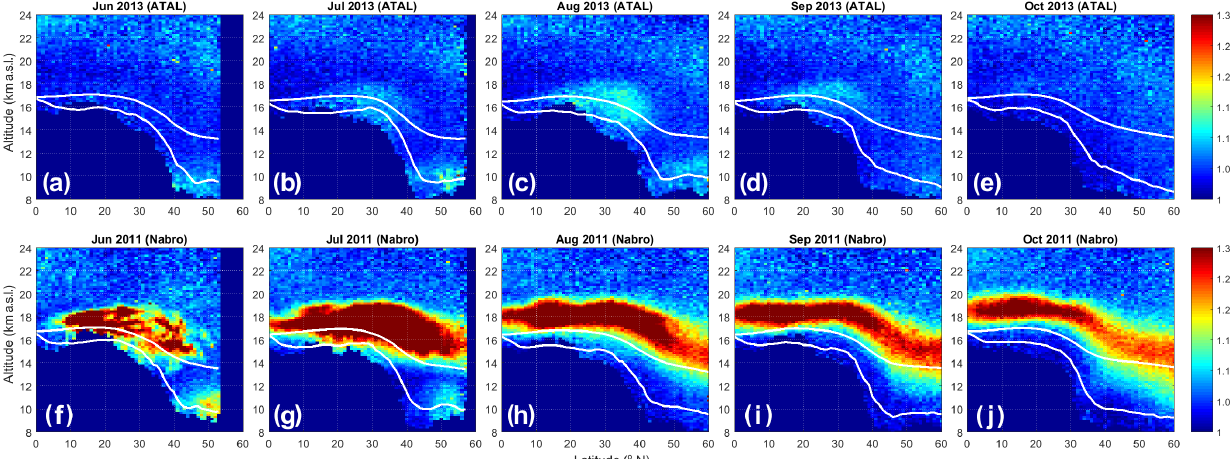
Figure 8. Latitude and altitude distribution of scattering from aerosol in the stratosphere and the UT. Two series, from 2013 (upper row, a–e ) and 2011 (lower row, f–j ), show the monthly mean 532nm wavelength scattering ratio from June to October without and with, respectively, fresh volcanic influence. The former series allows identification of the comparably weak ATAL in July to September. The lower series includes two volcanic eruptions: the high-altitude cloud from the tropical volcano Nabro (eruption in 12 June 2011) and the low-altitude and midlatitude faint volcanic cloud from Grimsvötn (21 May 2011). The two white lines in every graph show the monthly averaged positions of 380K potential temperature (upper line) and the 1.5PVU dynamical